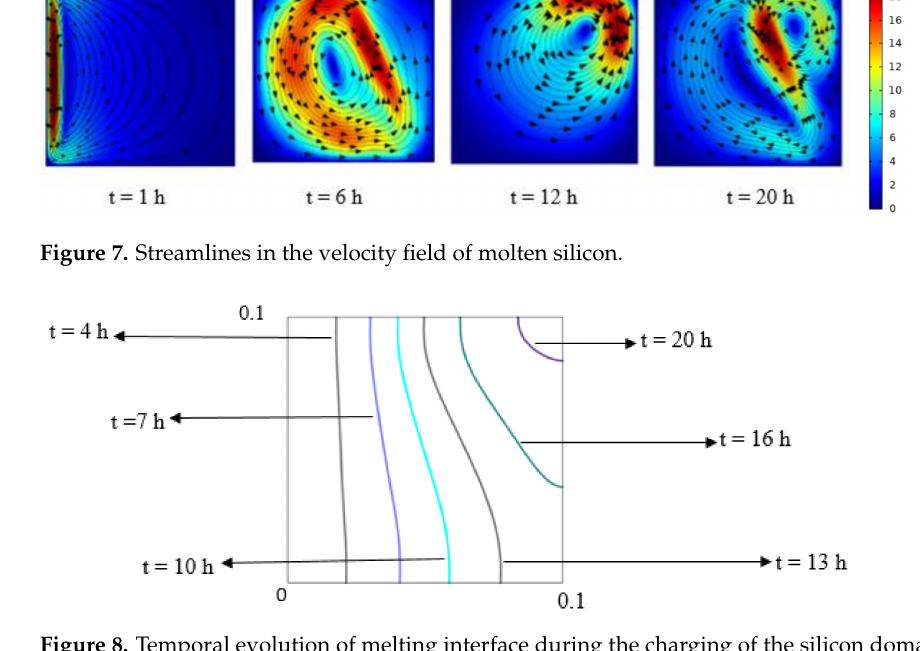
Figure 8. Temporal evolution of melting interface during the charging of the silicon domain.